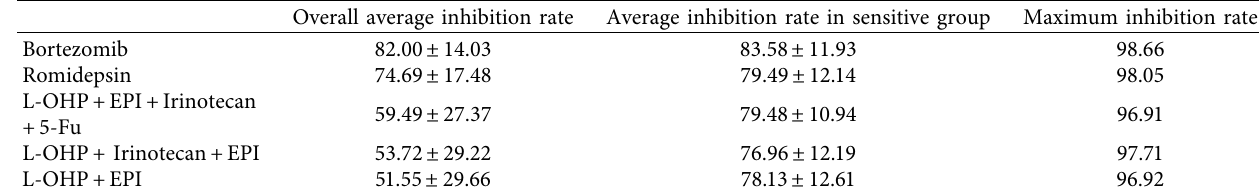
Figure 3: Inhibition rates of the five most effective drugs. Table 3: Inhibition rates of the five most effective drugs.